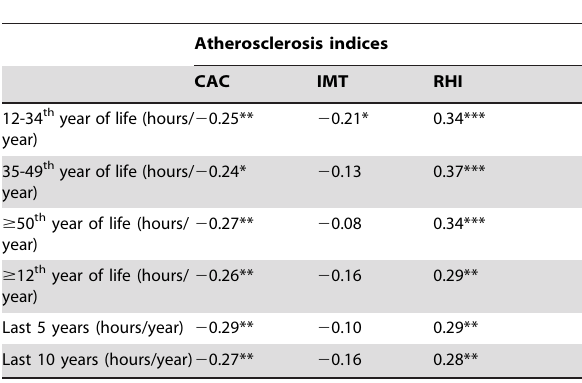
Table 4. Correlation coefficients of subclinical atherosclerosis indices to LTPA in different life periods assessed by historical PA